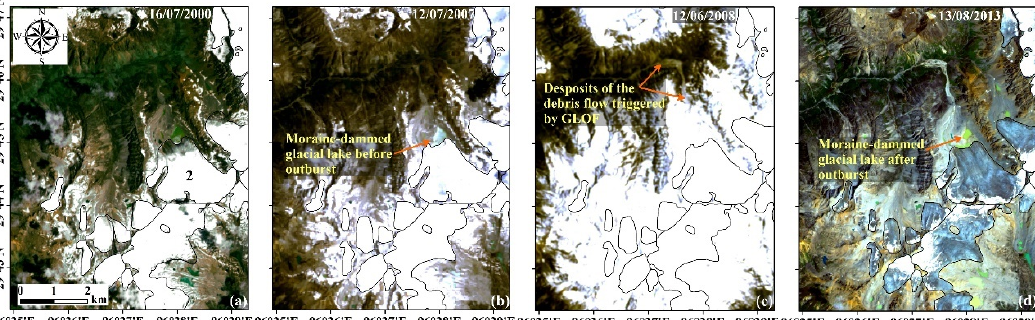
Figure 7. Development of the glacial lake ahead of glacier 2. The backgrounds of ( a – d ) are Landsat-7, Landsat-5, Landsat-5, and Landsat-8 images, respectively. The acquisition dates of the images are marked on the top of the panels. Black curves denote glacier outlines. Readers can find the location of the shown area by referring to the location of glacier 2 in Figure 1.